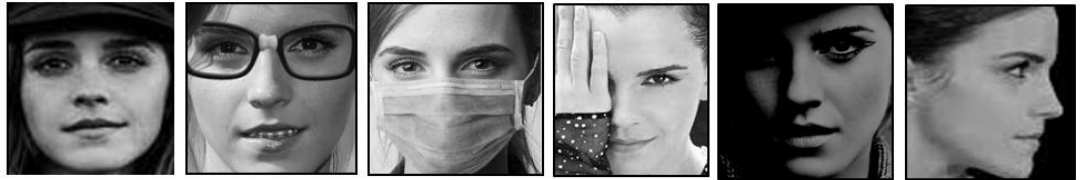
Figure 40. Some examples of occlusion by hat, glass, mask, hand, shadow, and self-occlusion.